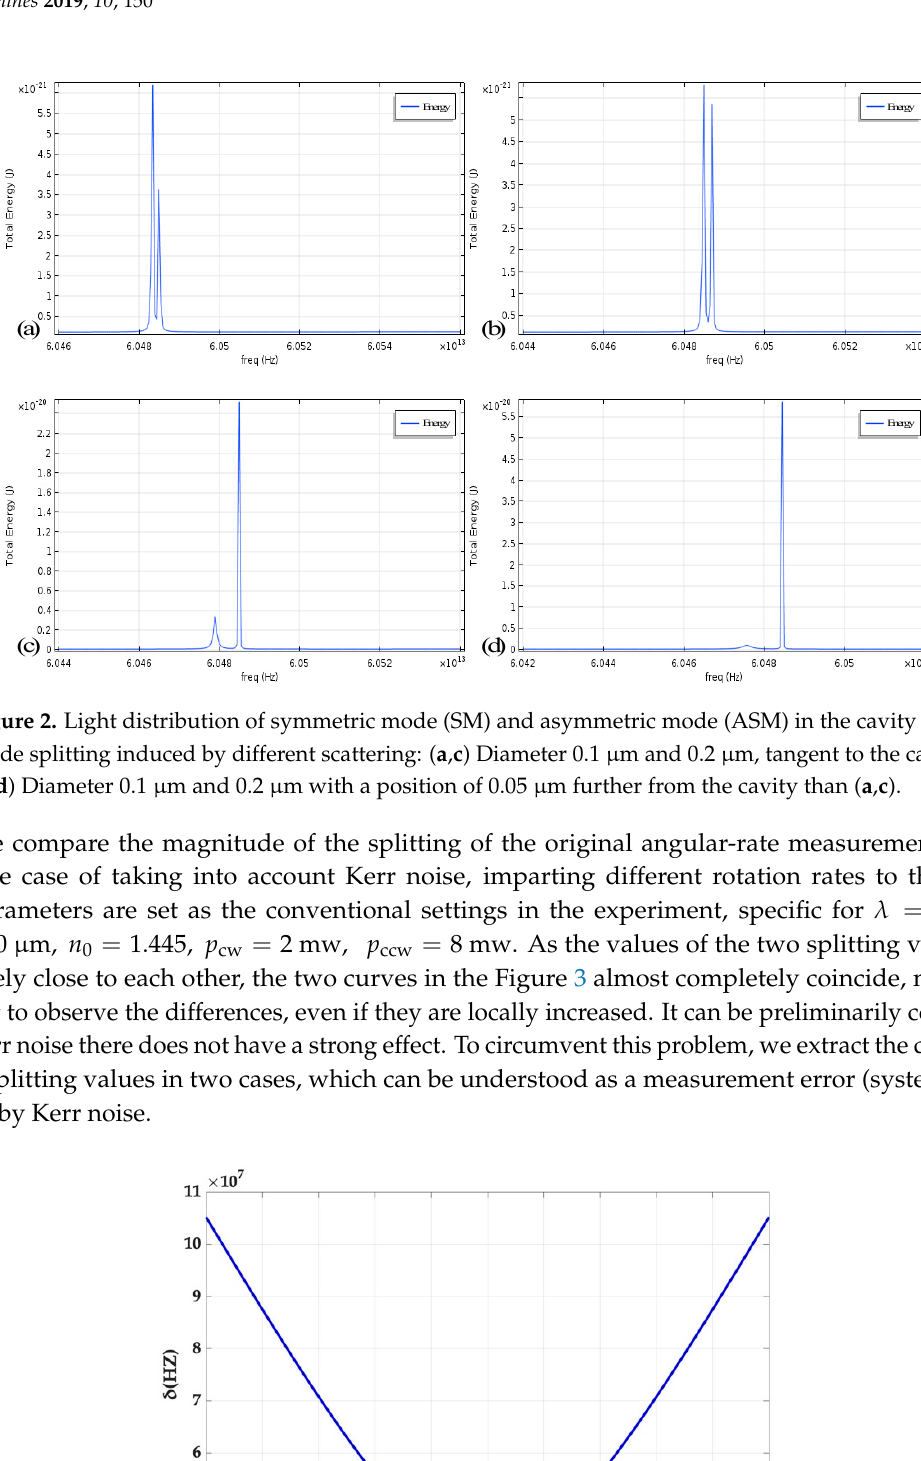
Figure 4. Splitting value deviation caused by Kerr noise at different angular rates. As can be seen from Figure 4, the offset of the system output, induced by Kerr noise, increases with the rotation rate of the cavity and the gradient increases and approximately approaches a constant. However, it should be pointed out that the offset reaches only 1.913 × 10 − 5 Hz, even if the rotation rate is up to 5 × 10 6 ° /s, which corresponds to the splitting amount of 1.05 × 10 8 Hz in Figure 3. This is also consistent with the previous result that the offset caused by Kerr noise is small. The relationship between the Kerr noise and the rotation angular rate of the resonator at 780 nm, 1064 nm and 1550 nm is also given in Figure 5. The output offset caused by Kerr noise decreases with